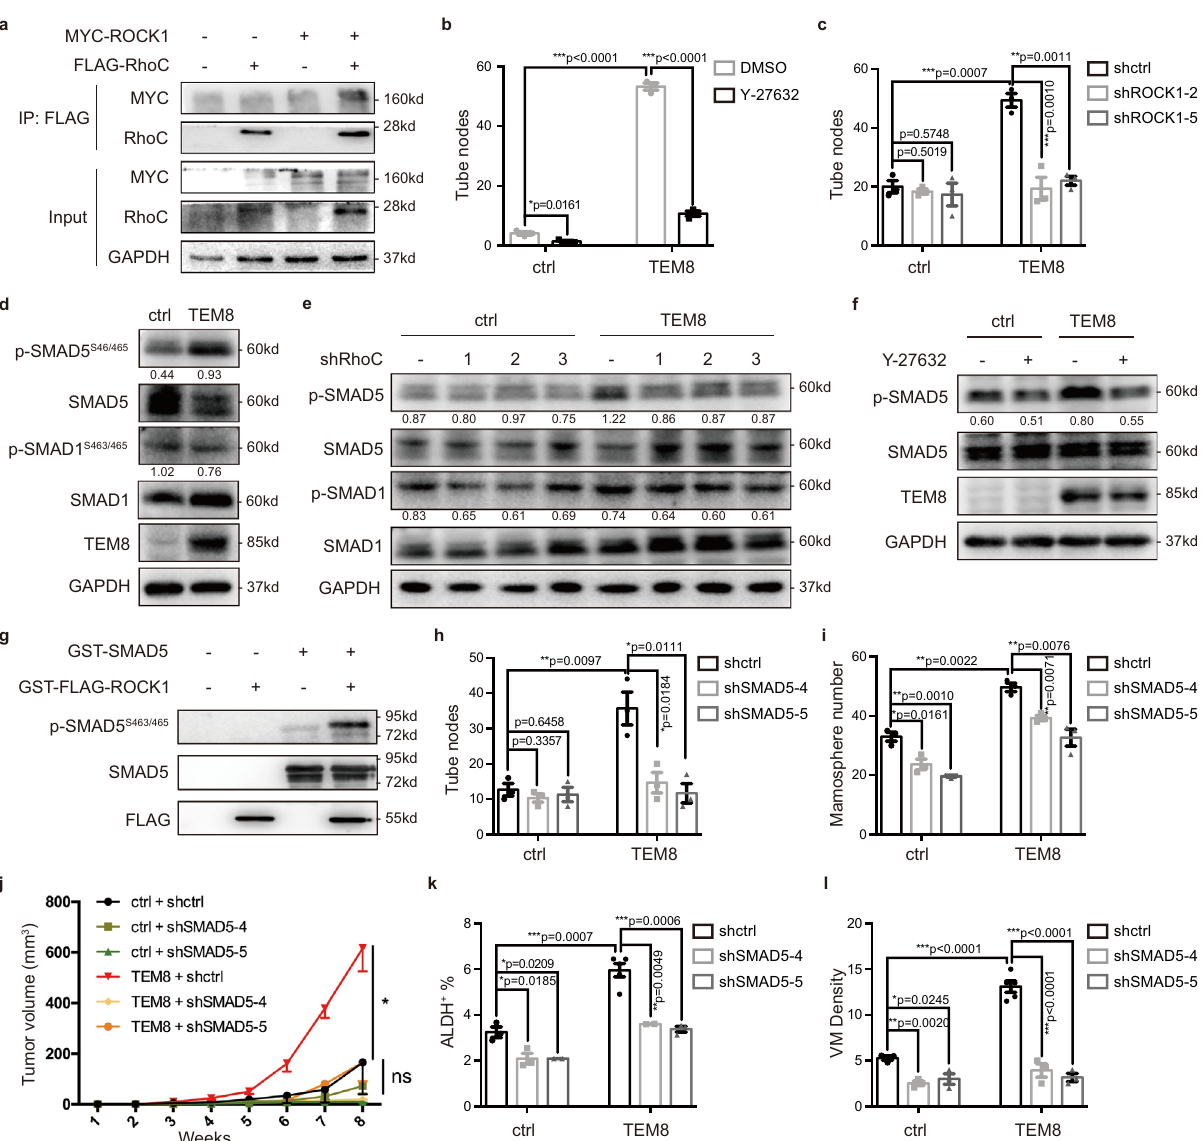
Fig. 4 RhoC/ROCK1/SMAD5 signaling pathway mediated TEM8-induced VM. a Co-IP assay analyzed the interaction between RhoC and ROCK1